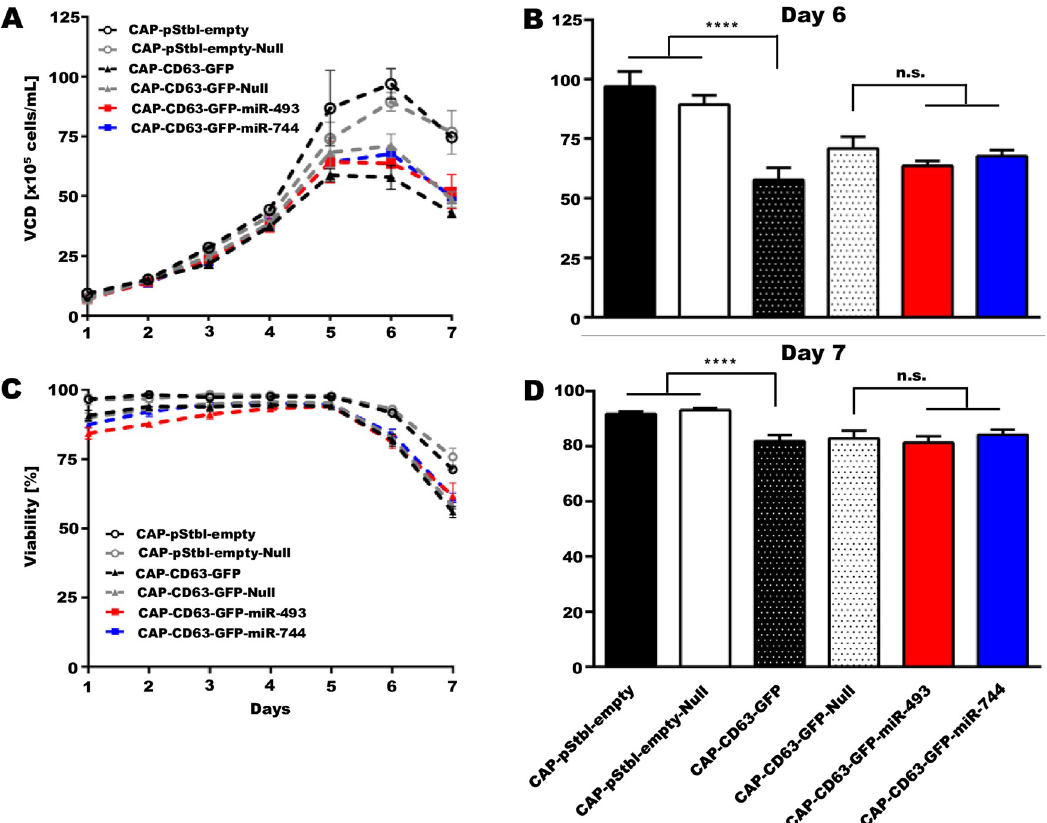
Fig 3. Impact of CD63-GFP and miRNA overexpression on CAP cell growth. ( A ) Viable cell density (VCD) of modified and of reference CAP cell lines during a 7 day cultivation, measured by trypan blue exclusion. ( B ) Viable cell density of modified and of reference CAP cell lines at day 6, measured via trypan blue exclusion. Significance was determined by using One-way ANOVA multiple comparison with Bonferroni correction [Each cell line cultured in 2 separate flasks; mean ± SD; n.s. = not significant, ���� < 0.0001]. ( C ) Viability of modified and of reference CAP cell lines during a 7 day cultivation, measured by trypan blue exclusion. ( D ) Viability of modified and of reference CAP cell llines at day 7, measured by trypan blue exclusion. Significance was determined by using One-way ANOVA multiple comparison with Bonferroni correction [Each cell line cultured in 2 separate flasks; mean ± SD; n.s. = not significant, ���� < 0.0001].